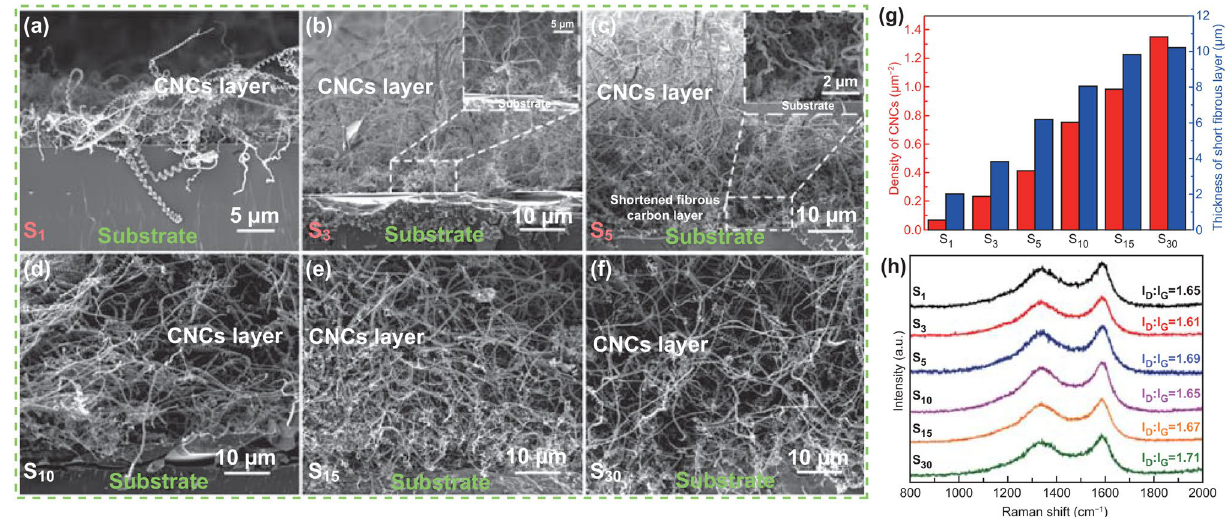
Fig. 3 Cross-sectional SEM images of CNCs synthesized using Fe/Sn catalyst films with spin-coating times of a one, b three, c five, d ten, e fif- teen, and f thirty times. g Effects of varying Fe/Sn catalyst density on the thickness of short fibrous carbon layers and density of CNCs. h Raman spectra of CNCs synthesized at different Fe/Sn catalyst